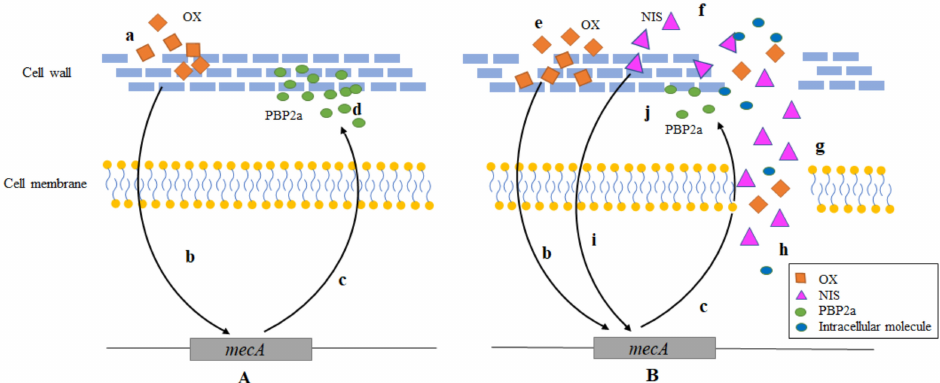
Figure 8. The schematic diagram of possible synergy antimicrobial mechanism of OX + NIS against MRSA. ( A ). The process of MRSA resistant to OX. OX contacts with MRSA cell wall to destroy cell wall synthesis (a); mecA is activated (b); MRSA expresses PBP2a (c), which has a lower affinity for OX; a large amount of PBP2a participates in cell wall synthesis and repairs the cell wall damage caused by OX (d); MRSA showed resistance to OX. ( B ). The synergy antimicrobial process of OX + NIS against MRSA. OX and NIS contact the MRSA cell wall, where OX destroys cell wall (e); NIS destroys cell wall and membrane (f), and forms pores (g); extracellular NIS and OX enter directly into the cell, caused leakage of intracellular molecules (h); NIS inhibits the transcription of mecA (i), reducing the synthesis of PBP2a (j), so the damage to the cell wall by OX cannot be adequately repaired. MRSA restores sensitivity to